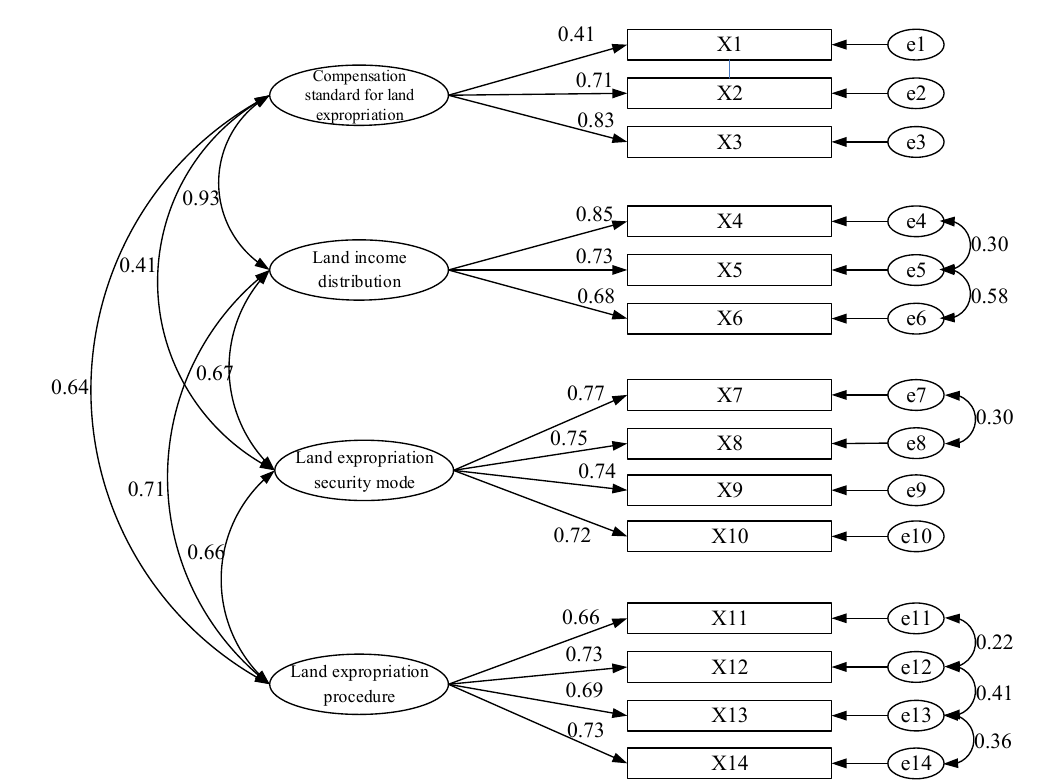
Figure 3. Modified structural equation model of farmers’ satisfaction. Note: The number in the figure represents the standardized path coefficient.